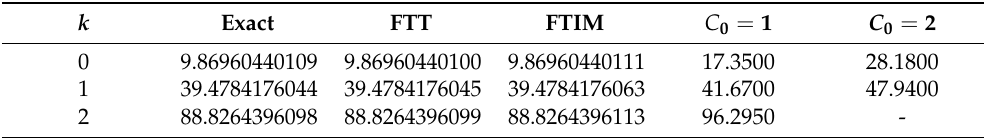
Table 1. Comparison of the eigenvalues for Example 1 with those calculated via Equation (40) using the initial conditions and with the present results and the exact